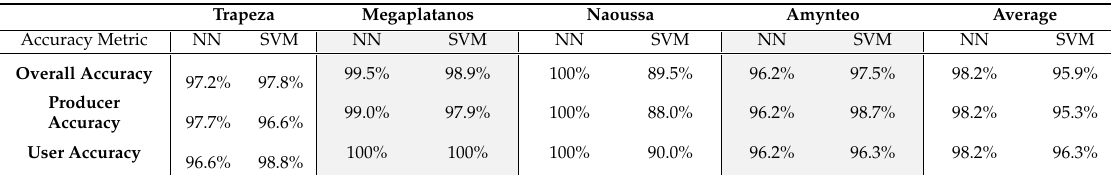
Table 3. Comparing results obtained from the proposed object-based NN classification framework and the pixel-based SVM classifier for vine canopy